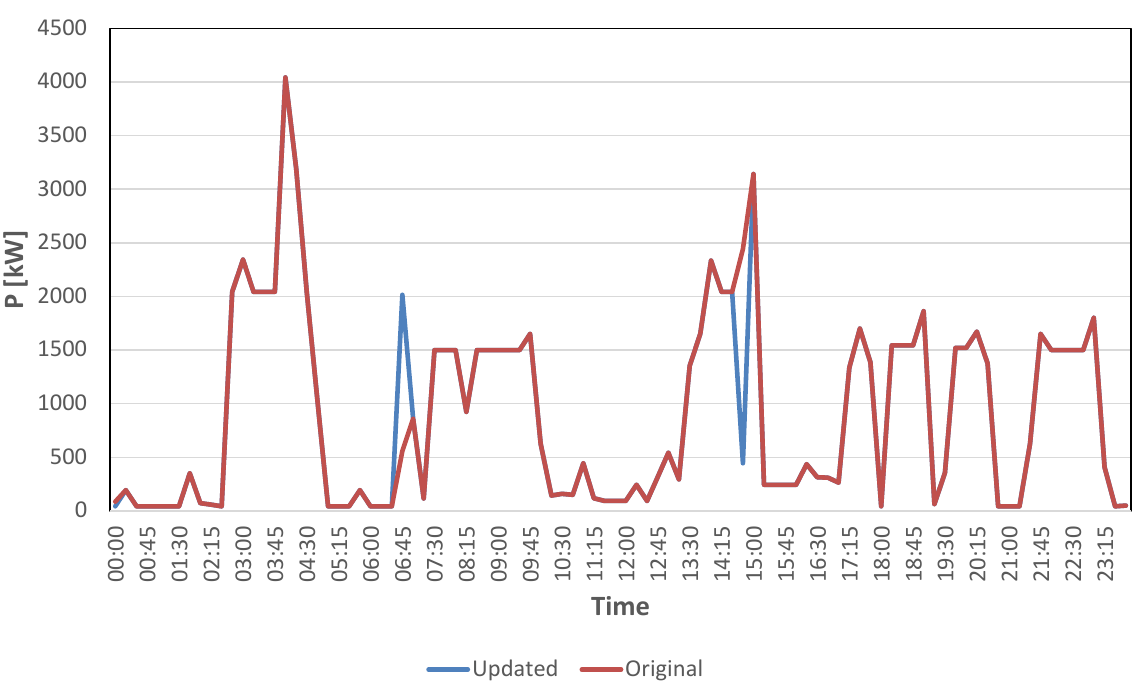
Figure 11. Comparison between updated and original load diagram after the second DR action.